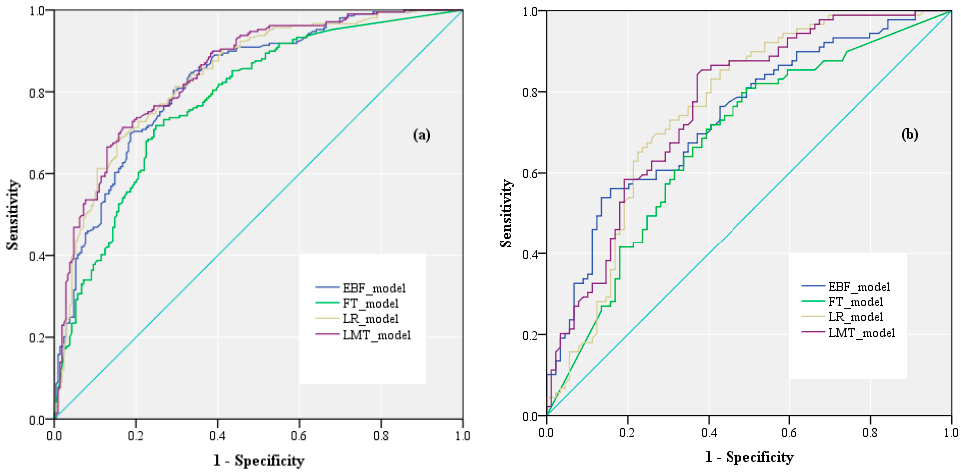
Figure 12. Receiver operating characteristic (ROC) curves: ( a ) training dataset; ( b ) validation dataset.